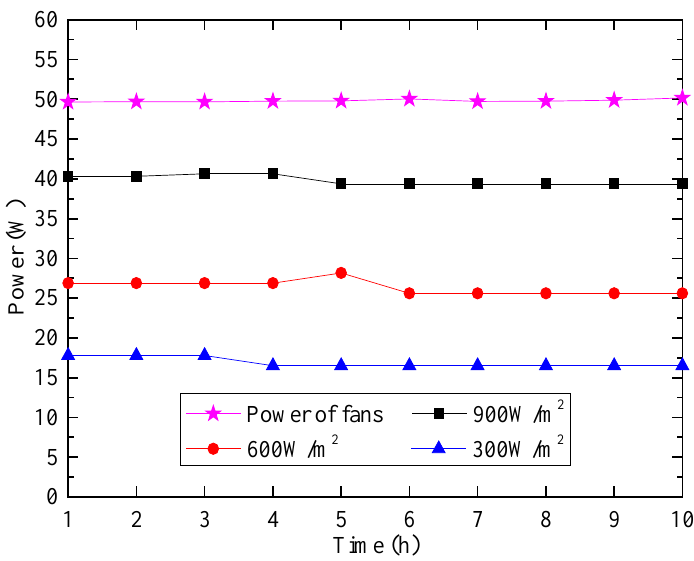
Figure 11. The variation of the power of the fans and photovoltaic (PV) panel with time.